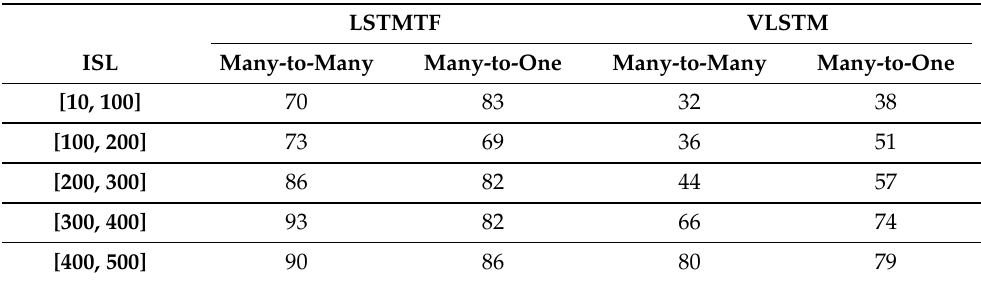
Table 4. The average training convergence time (epochs) for LSTMTF and VLSTM, computed with respect to the input sequence length, for (cid:101) = 1%, P = 5, and 1 lag for LSTMTF. LSTMTF VLSTM ISL Many-to-Many Many-to-One Many-to-Many Many-to-One [10, 100] 70 83 32 38 [100, 200] 73 69 36 51 [200, 300] 86 82 44 57 [300, 400] 93 82 66 74 [400, 500] 90 86 80 79